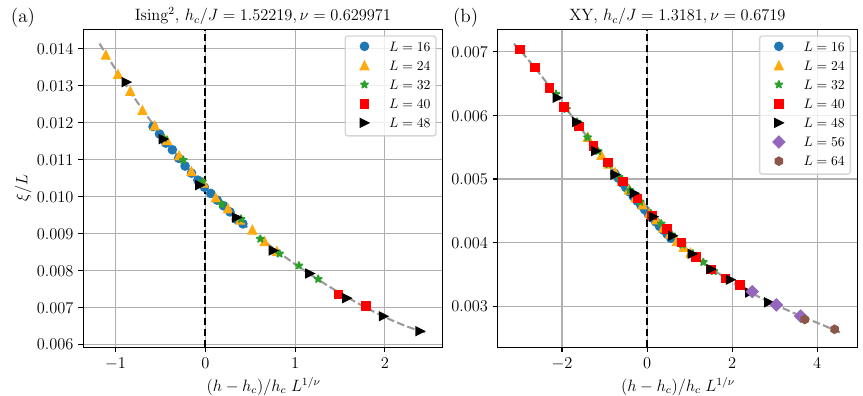
Figure 14: Collapse plots for the correlation length ξ across the Ising 2 (a), and the / J = 0.625 (b). The dashed, grey line shows a polynomial fit of XY transition at J AT the data as a guide to the eye. The known critical exponent ν [ 51 ] for the Ising (a) and XY transition (b) gives a good collapse of ξ